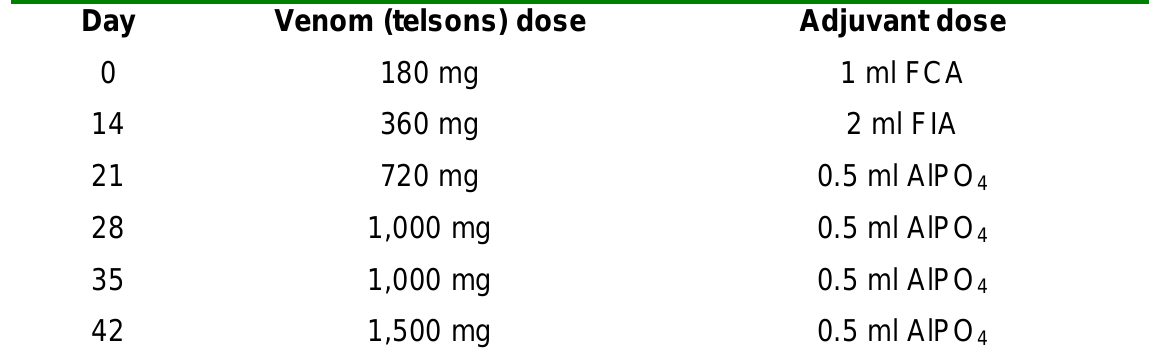
Table 1: Venom and adjuvant doses subcutaneously injected into each horse for